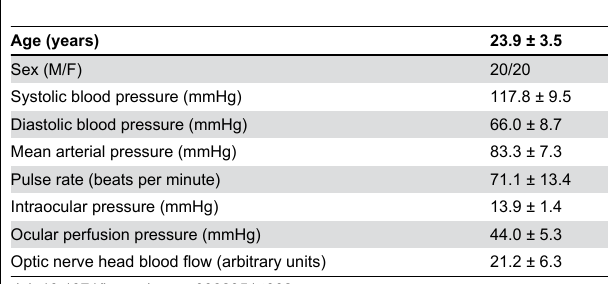
Table 2. Demographic and baseline characteristics of the subjects participating in the study (n=40, mean ±